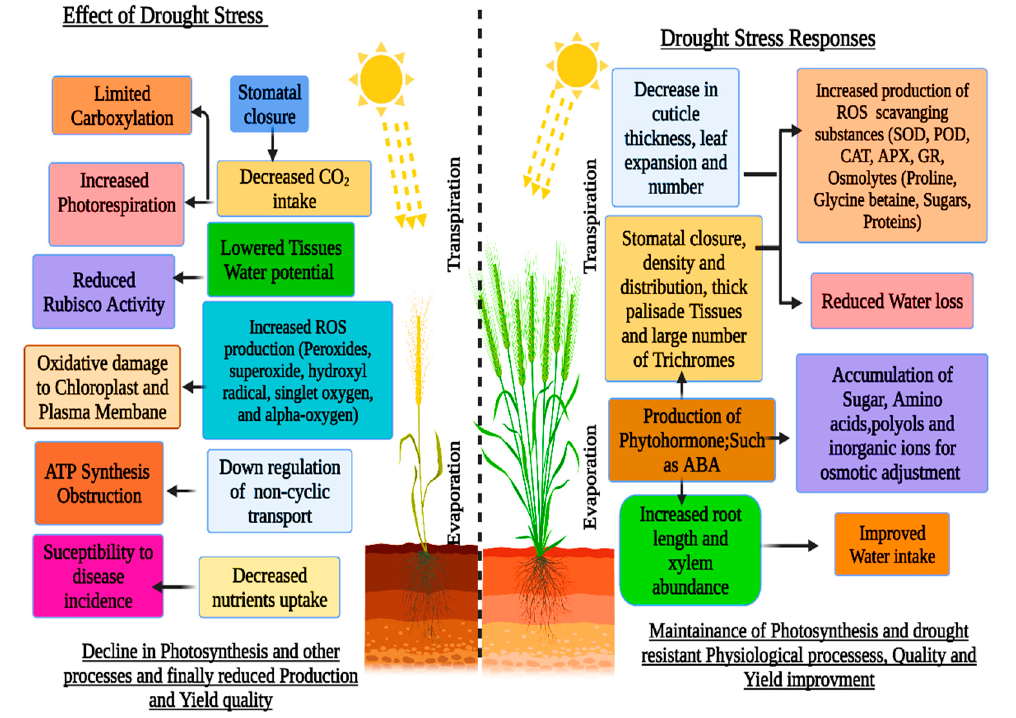
Figure 1. Effects of drought stress on sensitive and tolerant wheat ( Triticum aestivum L.) crops.